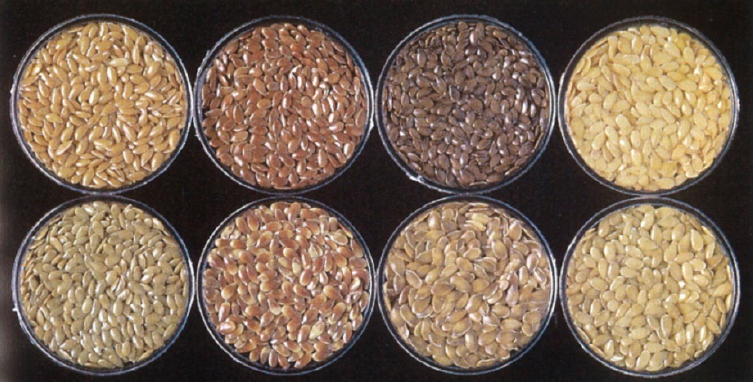
Figure 4. Variation in seed coat color observed in annual flax ( L. usitatissimum ). Lighter seed coats are desired for their aesthetic appeal [28,32] (figure adapted from Diederichsen and Richards, (2003)) [38].